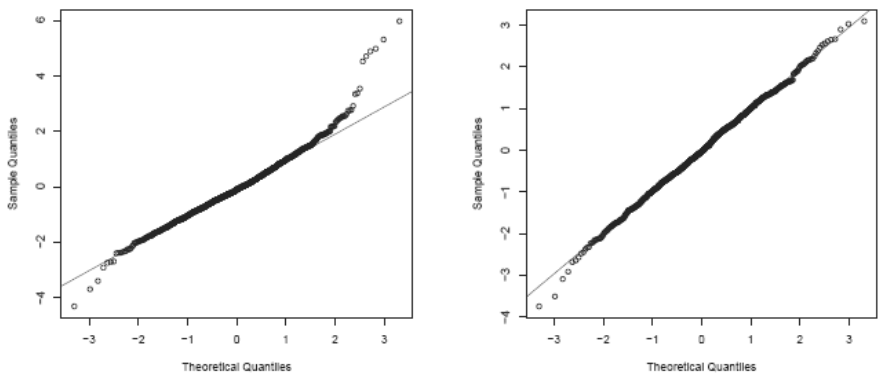
Figure 7 – Normal probability plot of randomized residuals for the Poisson model M 2 (left) and the Negative Binomial model M 3